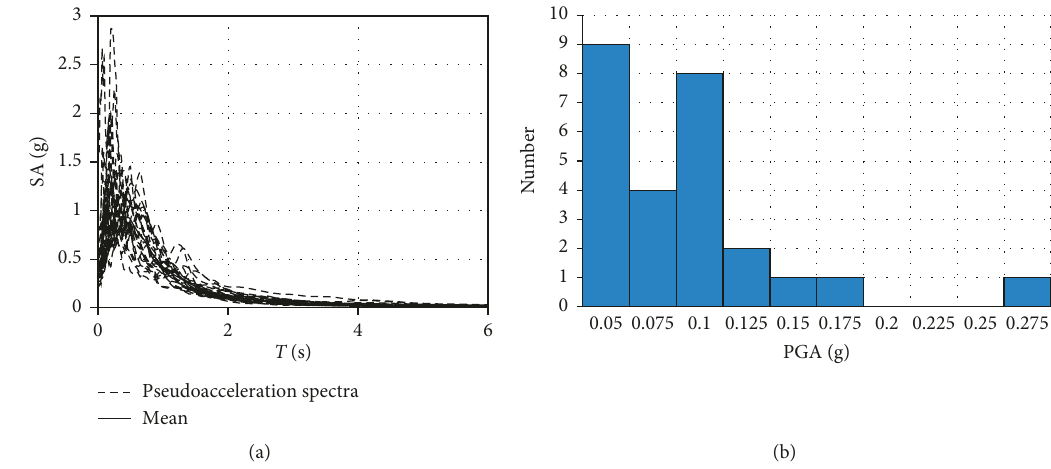
Figure 12: Property of the selected ground motions. (a) Response spectra. (b) Distribution of PGA.